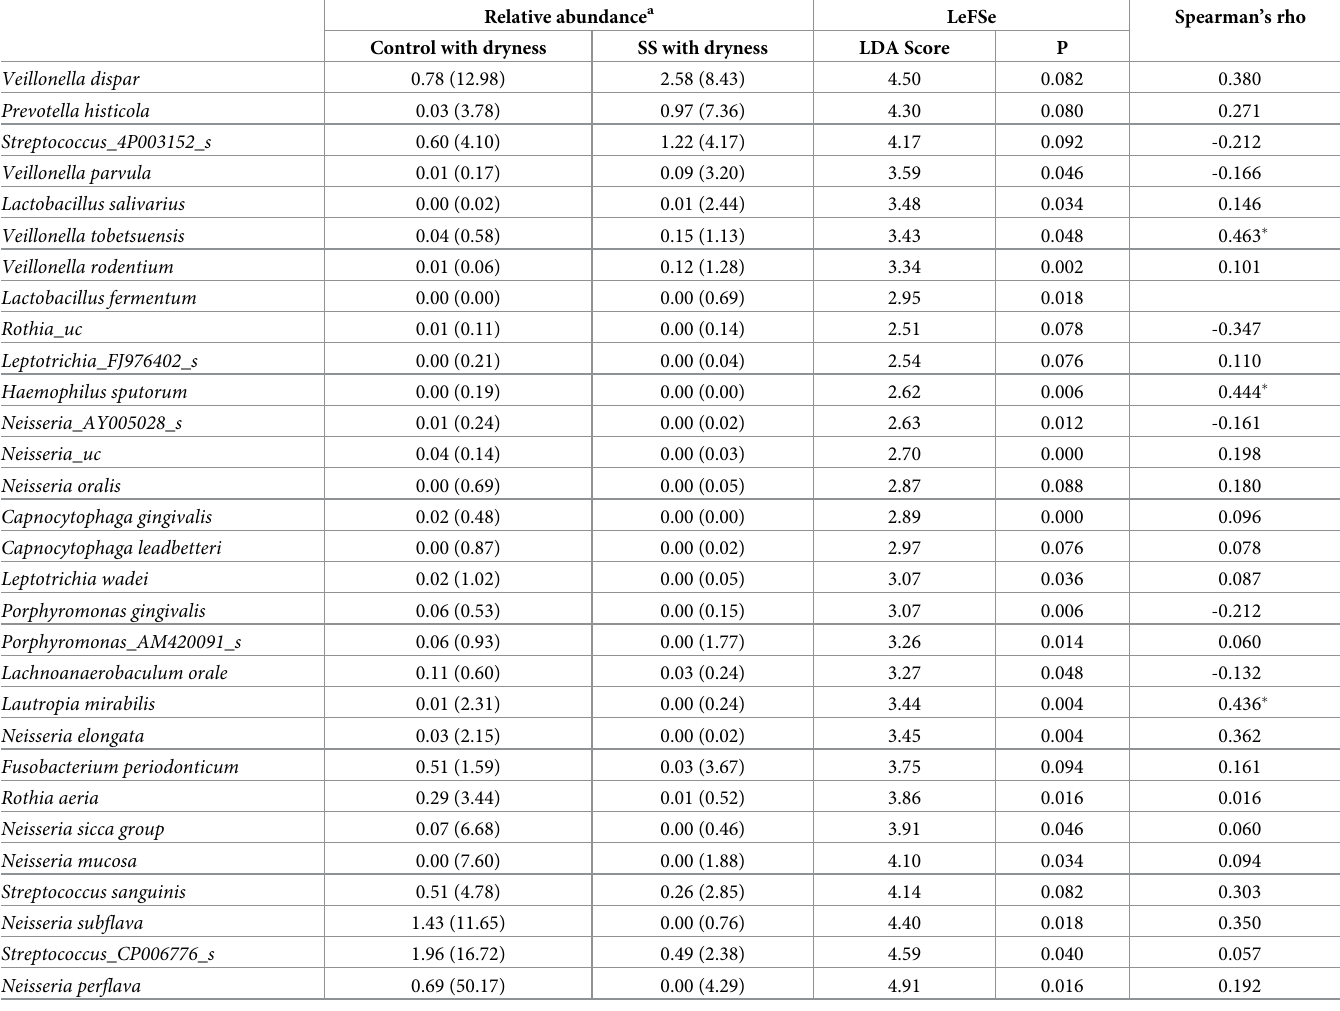
Table 4. Species associated with SS dryness (n = 17) vs. control dryness (n = 11).